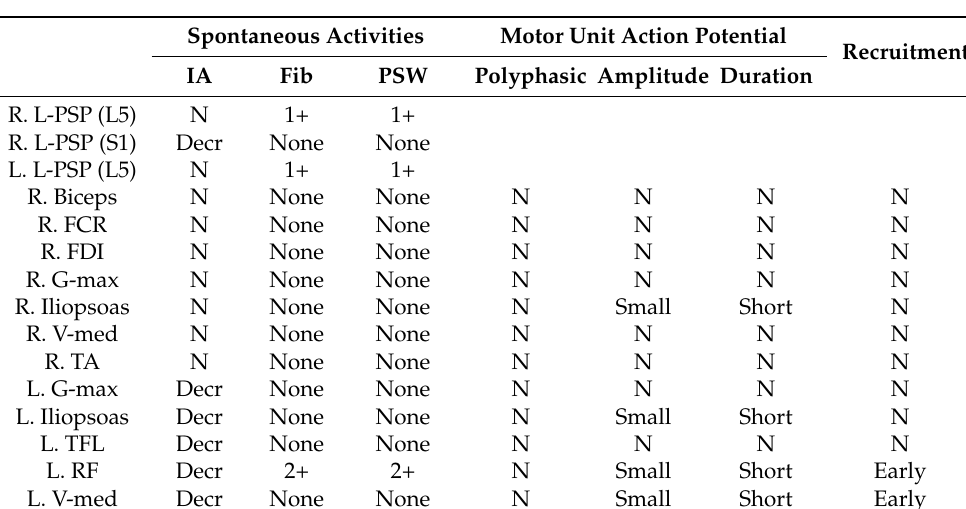
Figure 2. Results of magnetic resonance imaging (MRI) T1-dissusion ( A ) and T1-fat suppression ( B ) images of both thighs demonstrated diffuse high signal intensities on both thigh muscles (white arrows) and atrophy in the left buttock and thigh muscles. Table 1. Findings of needle